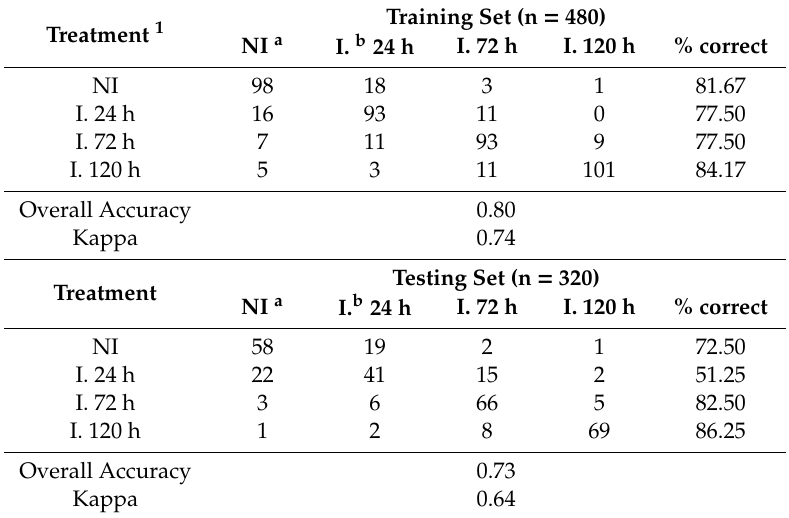
Table 1. Confusion matrices of the LDA model in training and testing sets using reflectance data of black oat seeds obtained at 19 wavelengths (365 to 970 nm) for class membership of non-inoculated (NI) and inoculated seeds (I) with Drechslera avenae (Eidam) Sharif for 24, 72 and 120 h. Training Set (n = 480) Treatment 1 NI a I. b 24 h